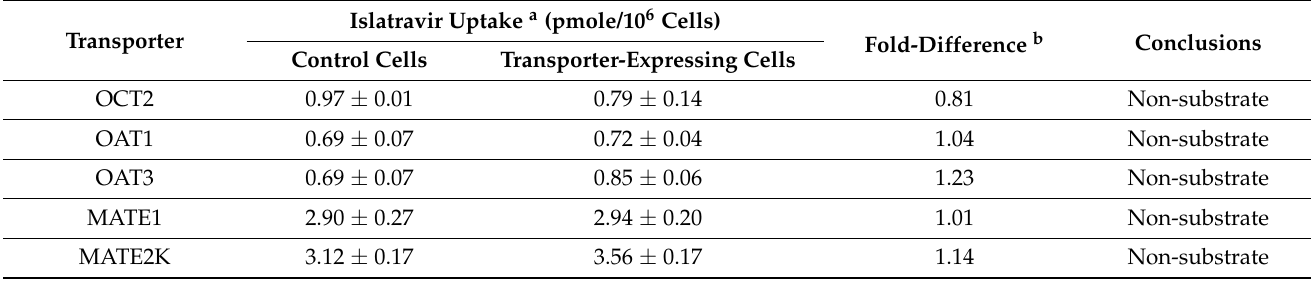
Fold-Difference b Conclusions